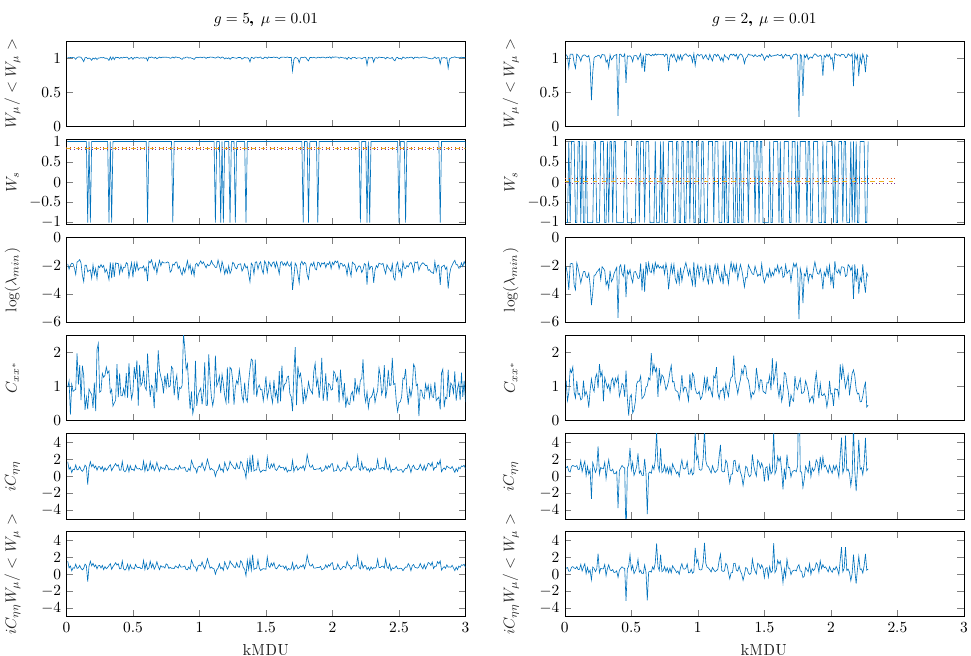
Figure 7 . Time history of the reweighting factors W C xx ( t ) and the fermionic correlator C (cid:17)(cid:17) ( t ) on two ensembles with L = 8, (cid:22) = 0 : 01 and g = 5 (left), g = 2 (right). The correlators are evaluated on a time-slice t = T= 4. The last three lines are normalized, so that they average to 1 (e.g. the third line is actually C xx = a clear \correlation" between spikes in W (cid:22) and the fermionic